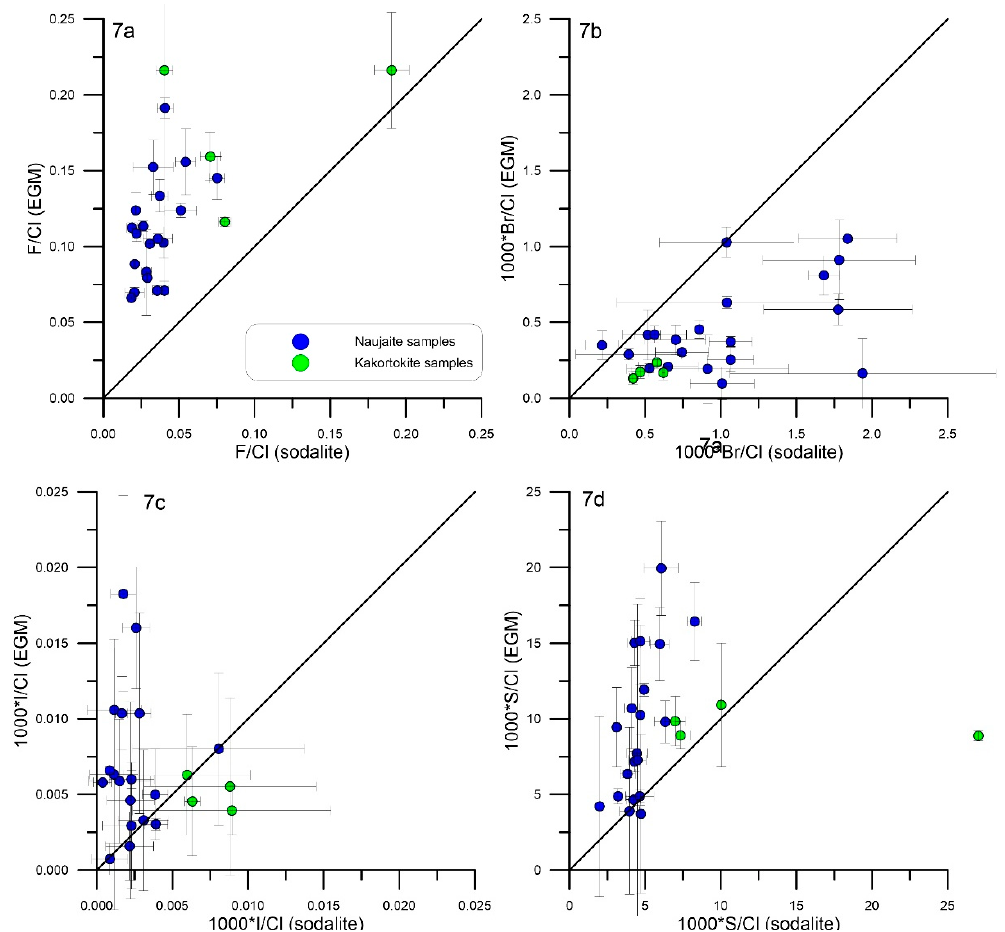
Figure 7. Comparison of ( a ) F/Cl, ( b ) Br/Cl, ( c ) I/Cl and ( d ) S/Cl, ratios between EGM and sodalite from the same rock samples. Sodalite seems to prefer Br compared to EGM, which relatively